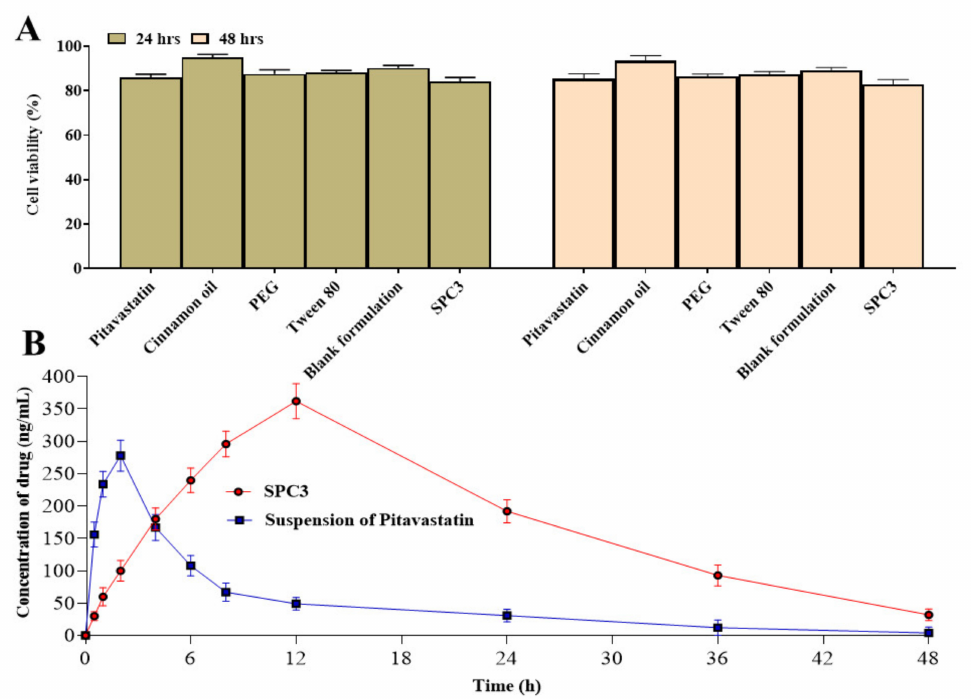
Figure 7. Cytotoxicity study of drug, excipients, blank formulation and SPC3 ( A ) and pharmacoki- netic analysis of pitavastatin from SPC3 ( B